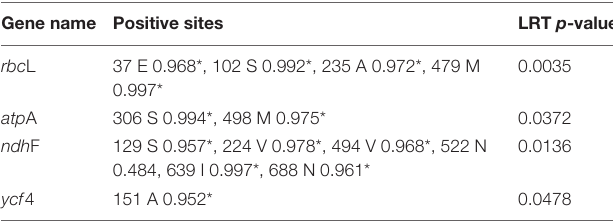
TABLE 2 | Positively selected genes and sites detected in the plastomes of Dolomiaea